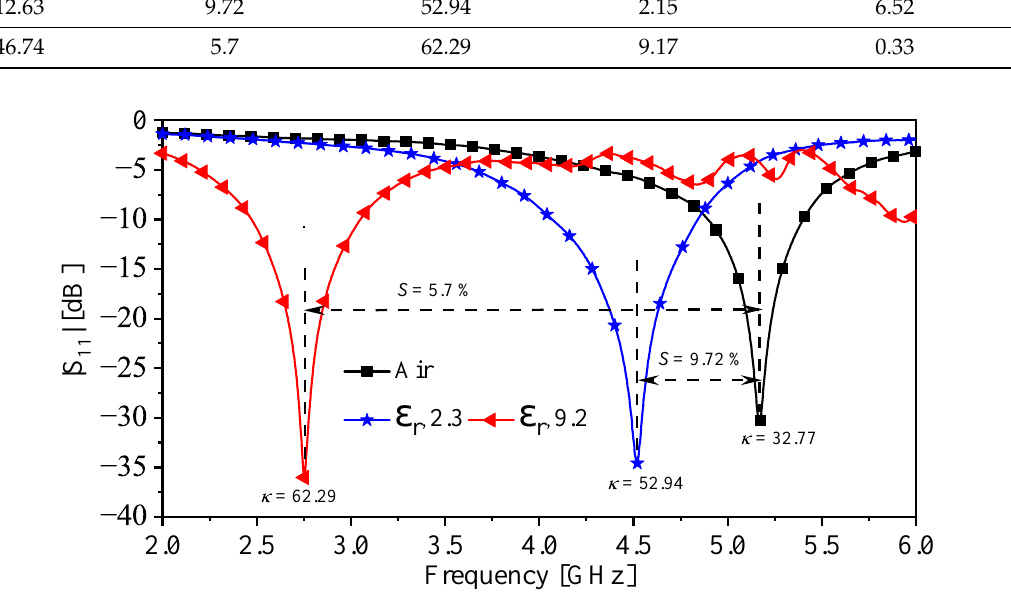
Figure 15. A descriptive response ( | S 11 | ) extracted experimentally from the proposed sensor in the presence of the MUTs, the free space, Rogers RT/duroid 5870, and TMM10